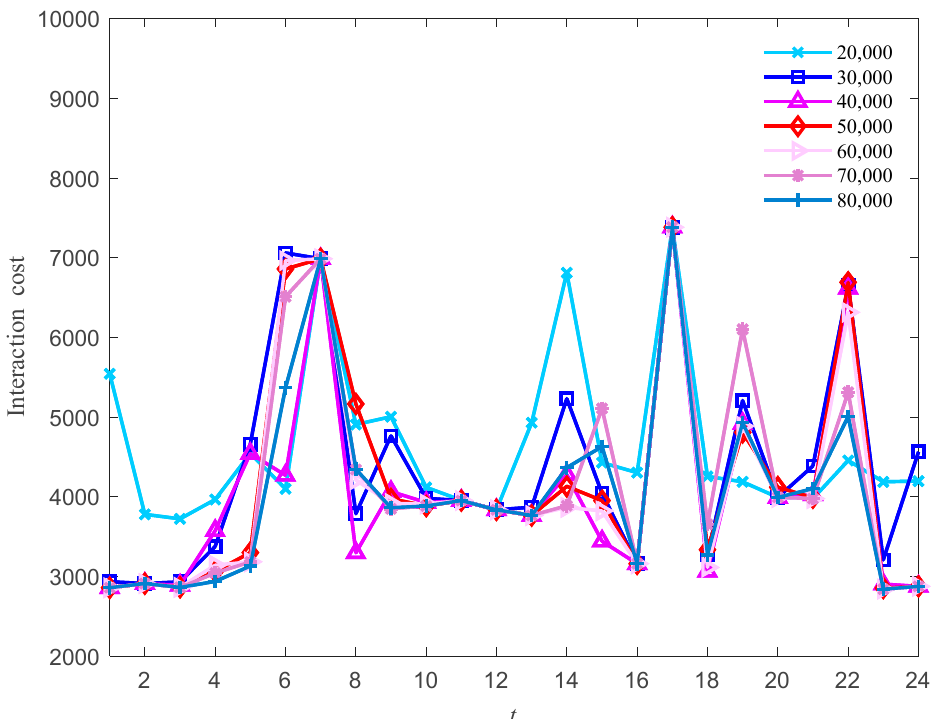
Figure 7. Interaction cost obtained with different scales of EVs. Different wind power: Table 14 shows the extreme solutions obtained with different wind powers. The best cost 2.4294 × 10 (cid:2874) $ is obtained when the 𝑃 (cid:3045)(cid:3028)(cid:3047)(cid:3032) is 200 MW. With the increase in wind power, the optimal emission is reduced. This indicates that as wind power increases, the power generated by conventional thermal units can be reduced, but the cost of wind power generation also increases, resulting in a consistent increase in the total cost. Table 14. The extreme solutions obtained with different wind power.